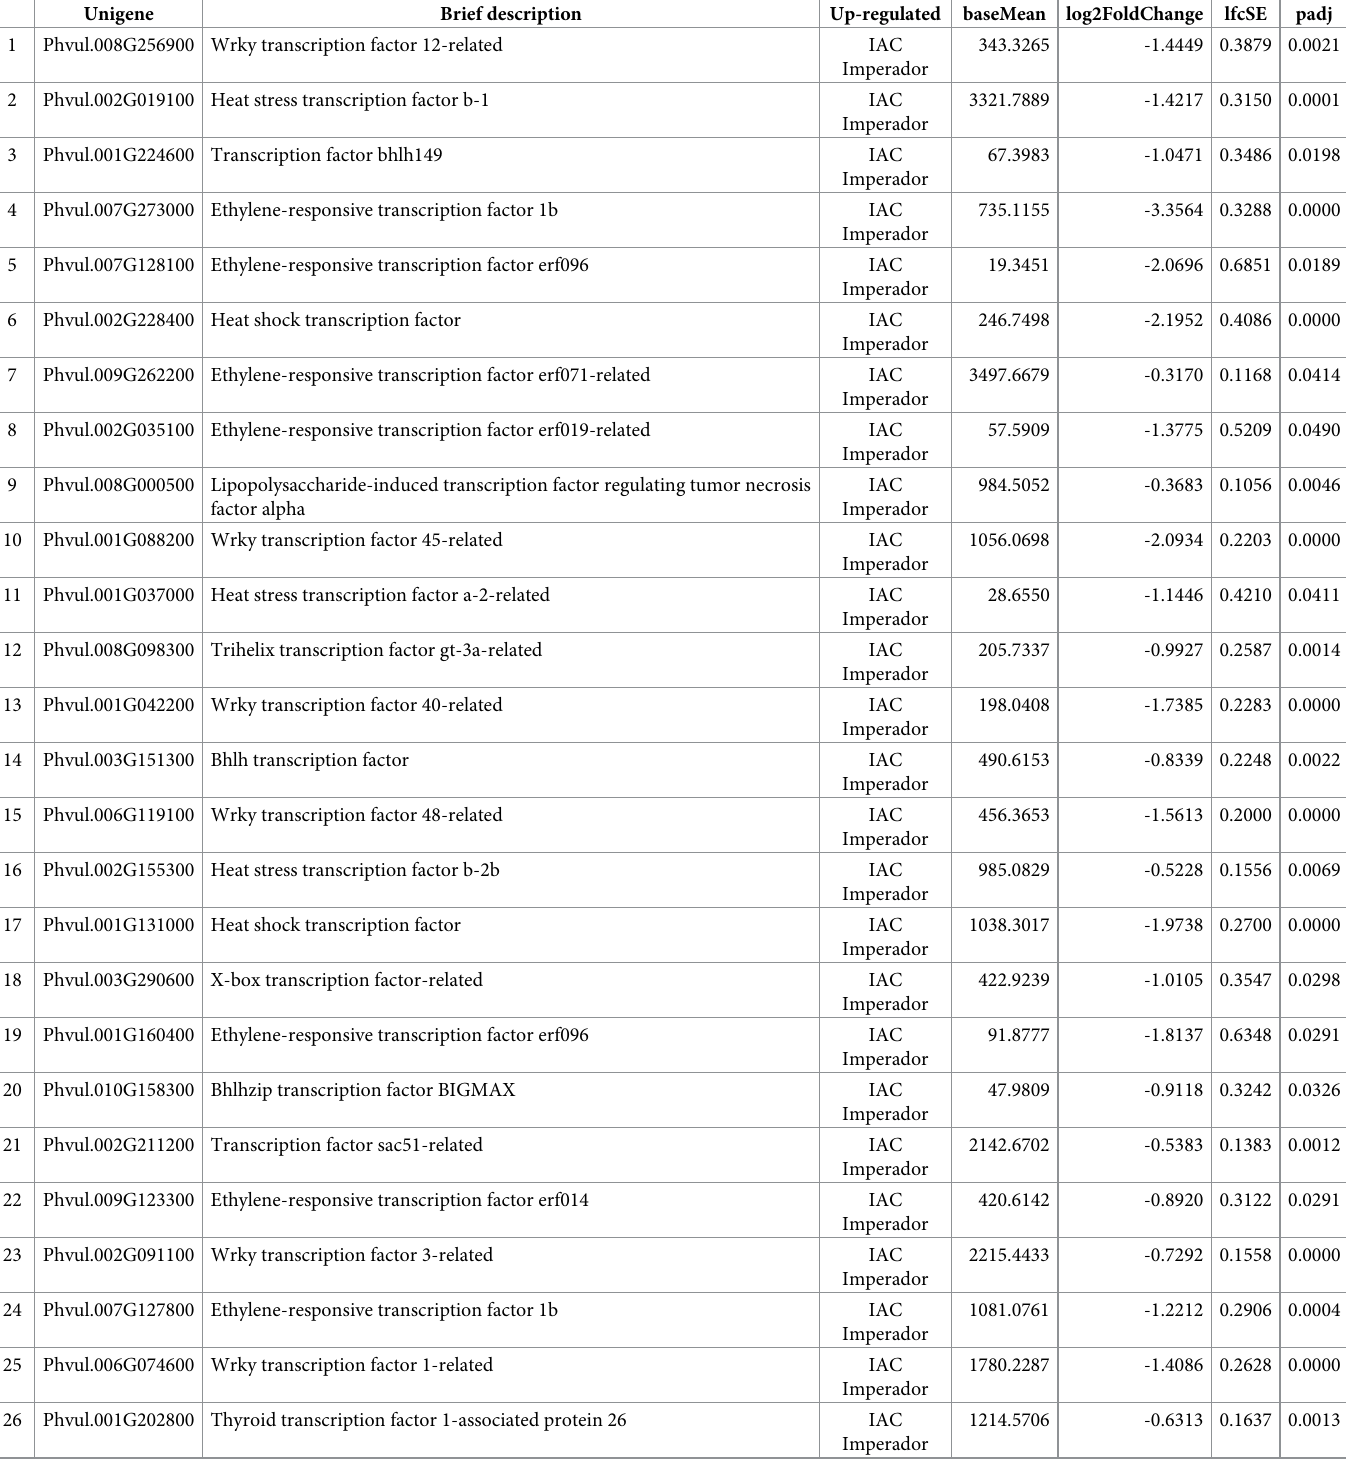
Table 5. Up-regulated transcription factor unigenes in IAC Imperador and DOR 364 under phosphorus restriction.